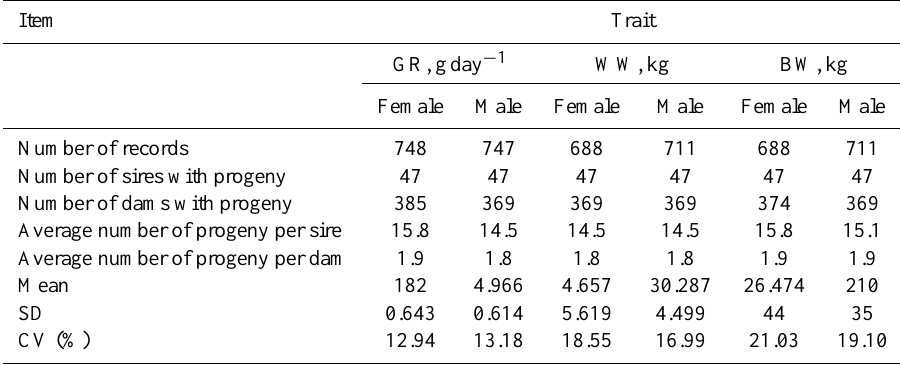
Table 2. Characteristics of the data structure. Item Trait GR, gday − 1